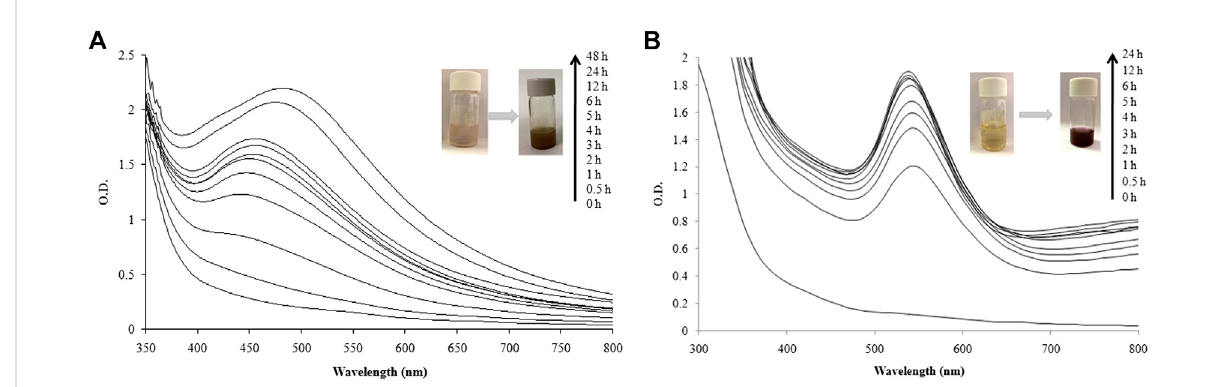
FIGURE 1 UV-visible spectra recorded as a function of reaction time for nanoparticle synthesis using LFLE. (A) AgNPs; and (B) AuNPs.